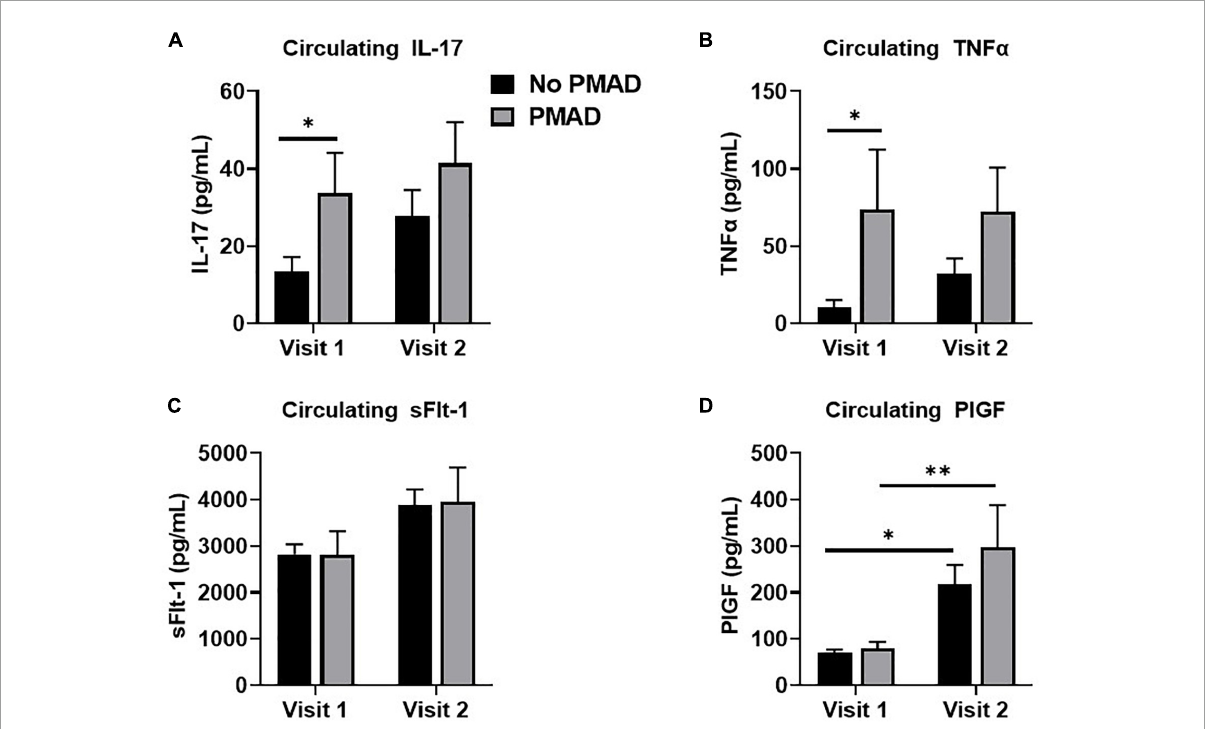
FIGURE3 Measurement of circulating levels of IL-17 (A) , TNF α (B) , sFlt-1 (C) , and PLGF (D) showed varying levels across visits for women with PMAD. ∗ and ∗∗ denotes p <